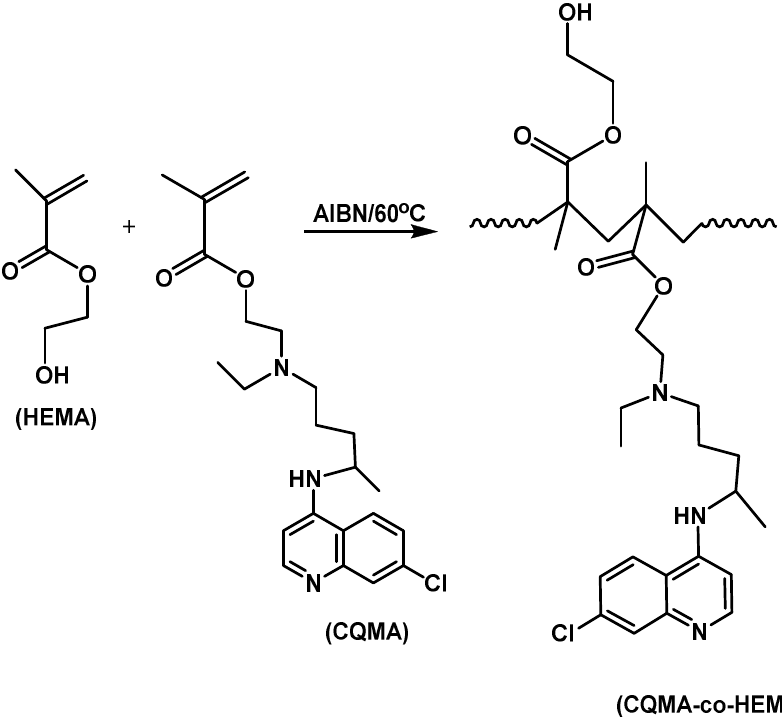
Table 2. Experimental conditions of the synthesis of CQMA-co-HEMA copolymer with different CQMA content.